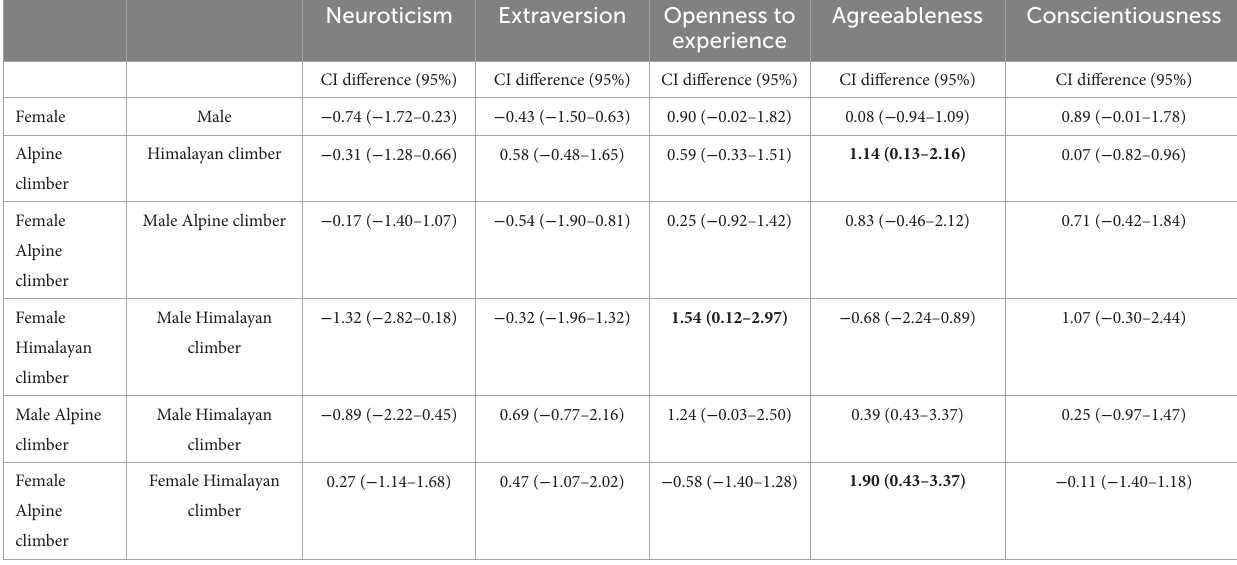
TABLE 5 Results of pairwise comparisons with confidence